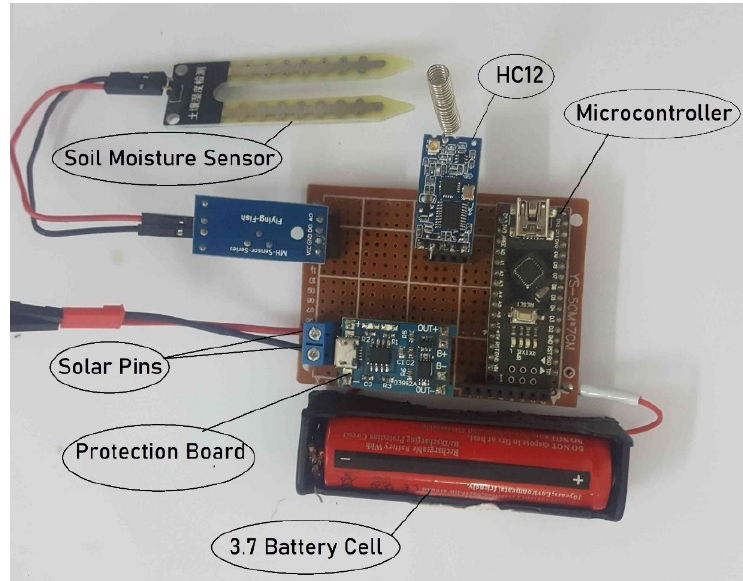
Figure 3. Physical diagram of sensor node.